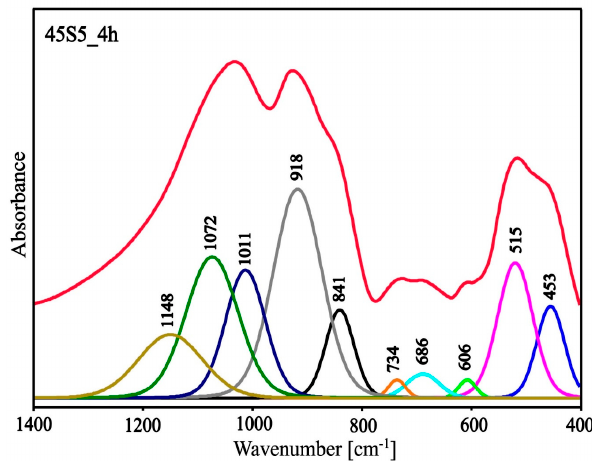
Figure 10. Deconvoluted MIR spectrum of the 45S5_4h sample.